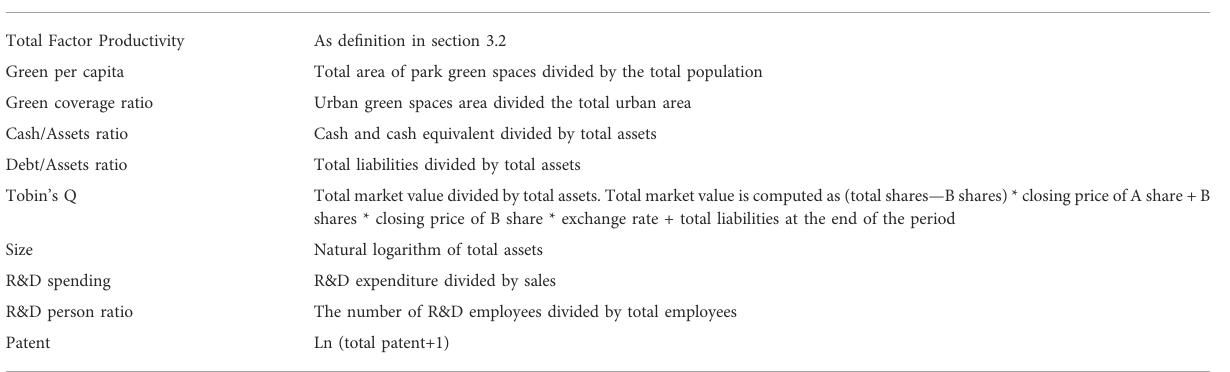
TABLE A1 De fi nition of